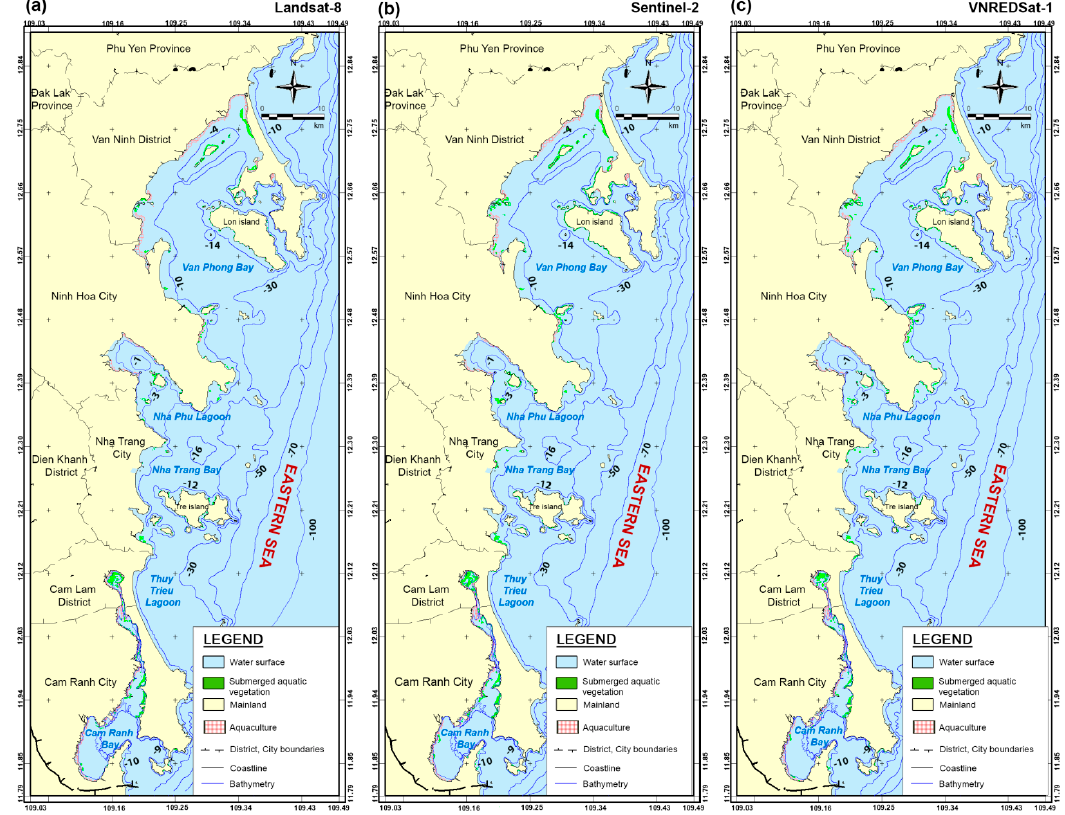
Figure 5. SAV distribution maps along the Khanh Hoa coast, created using data from three satellites: ( a ) Landsat-8 (2018), ( b ) Sentinel-2 (2019), and ( c ) VNREDSat-1 (2017).